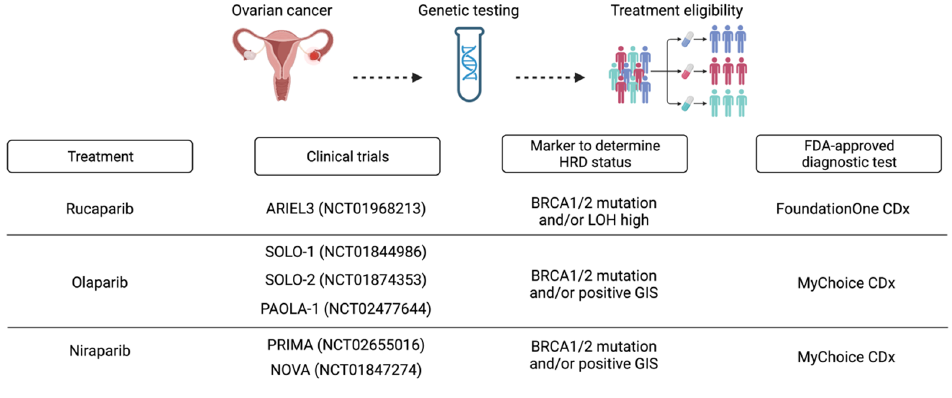
Figure 3. HRD analysis at diagnosis to determine treatment eligibility in ovarian cancer. Created with with BioRender.com.